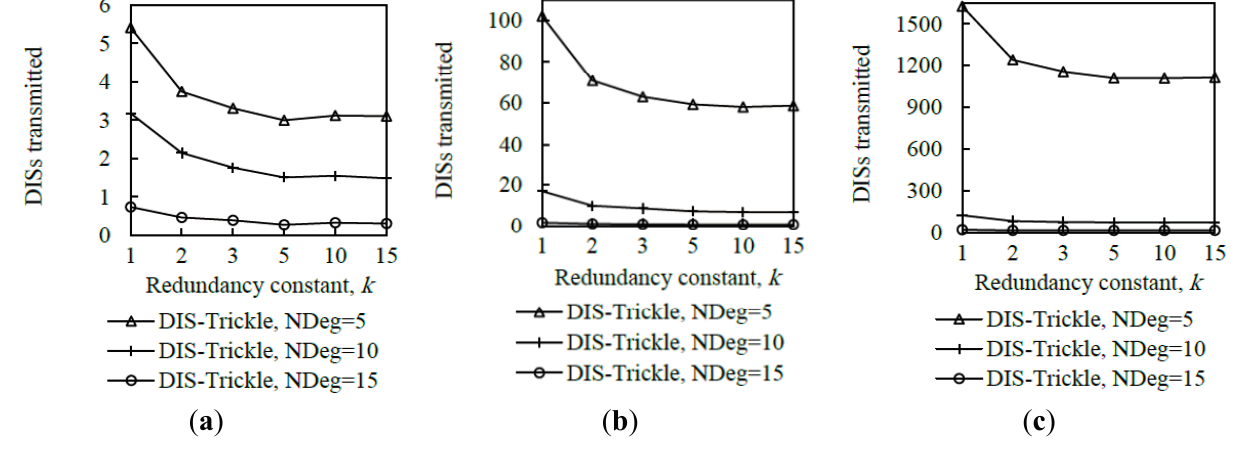
Figure 18. Influence of using DIS-Trickle on the number of DIS messages transmitted in the small, medium and large networks, for different average node degrees as a function of value is set to 8 ms. ( a ) Small network size, the redundancy constant, k . when the I min ( b ) medium network size, and ( c ) large network